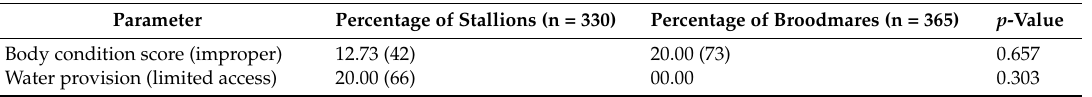
Table 3. The prevalence of parameters assessed for the investigation of freedom from hunger and thirst in each breeding horse category.